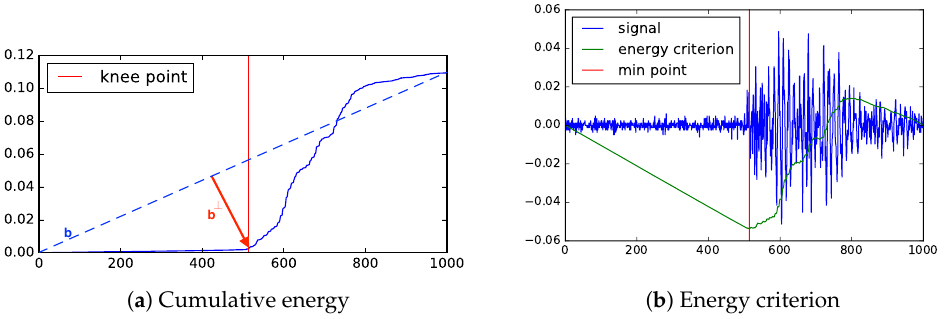
Figure 2. Two state-of-the-art timing methods. The horizontal axis is time steps and the vertical axis is energy (in V 2